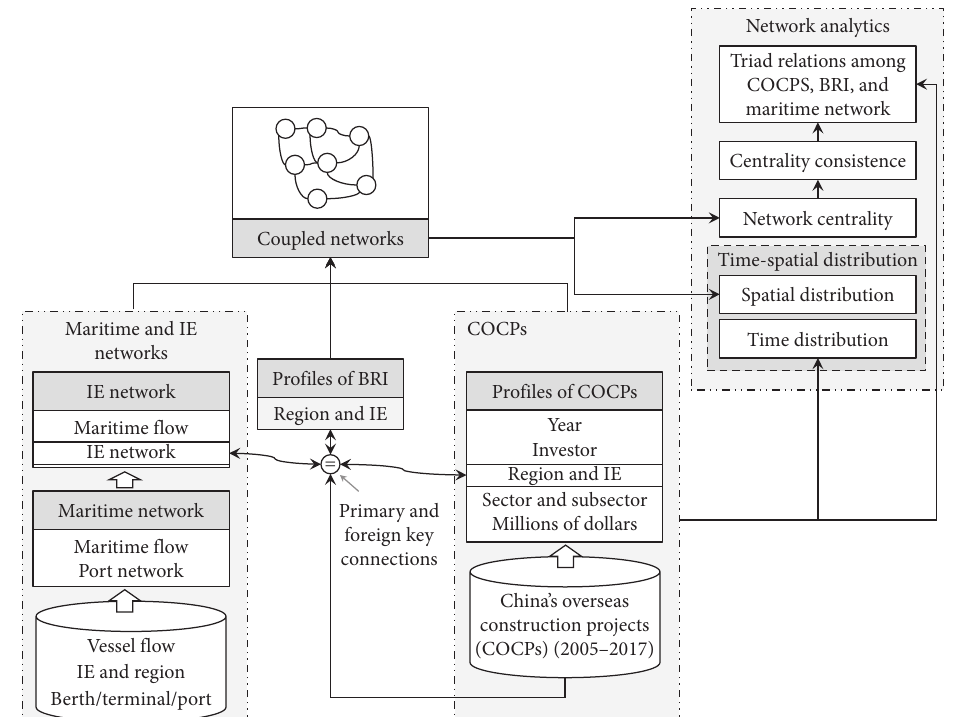
Figure 2: The systemic analyzing